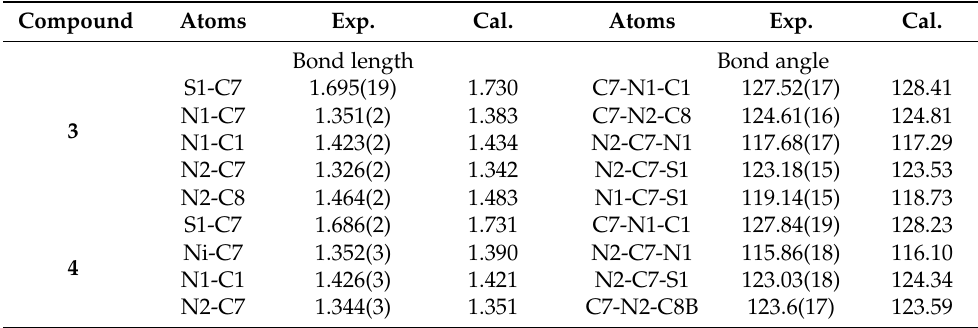
Table 2. Experimental and theoretical (B3LYP/3-21G level) selected structural parameters, bond lengths and angles of compounds 3 and 4 .